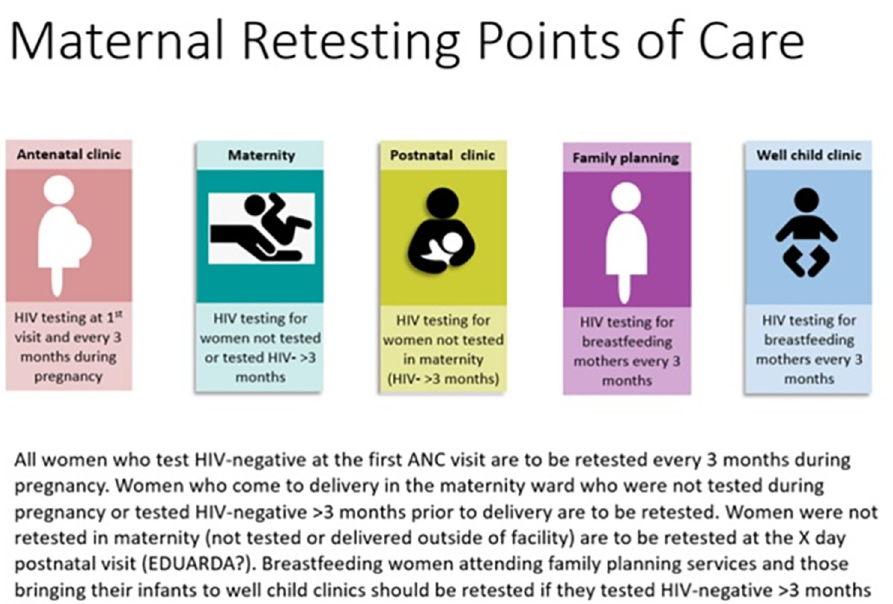
Fig 1. Maternal testing and retesting points of care per Mozambique’s national guidelines (2015) [15].